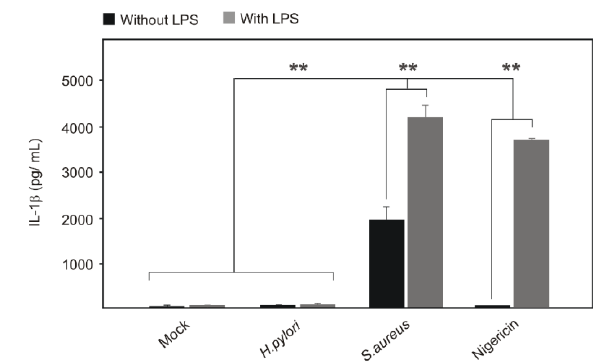
Figure 8. THP1 monocytes were infected with S. aureus and the level of mature IL-1 β secretion was compared with LPS / Nigericin treatment and H. pylori infection. S. aureus infection secreted comparable levels of LPS / Nigericin treatment, which shows canonical NLPR3 inflammasome activation by this bacterial activator in monocytes and confirms the inability of H. pylori to activate this innate immune function. ** p ≤ 0.05